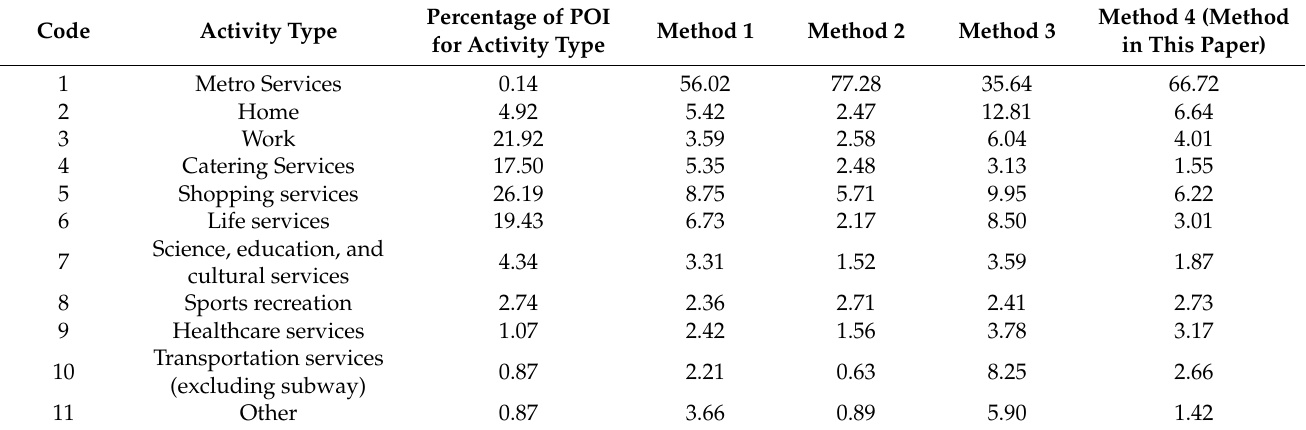
Table 2. The purpose of the trip inferred the result.